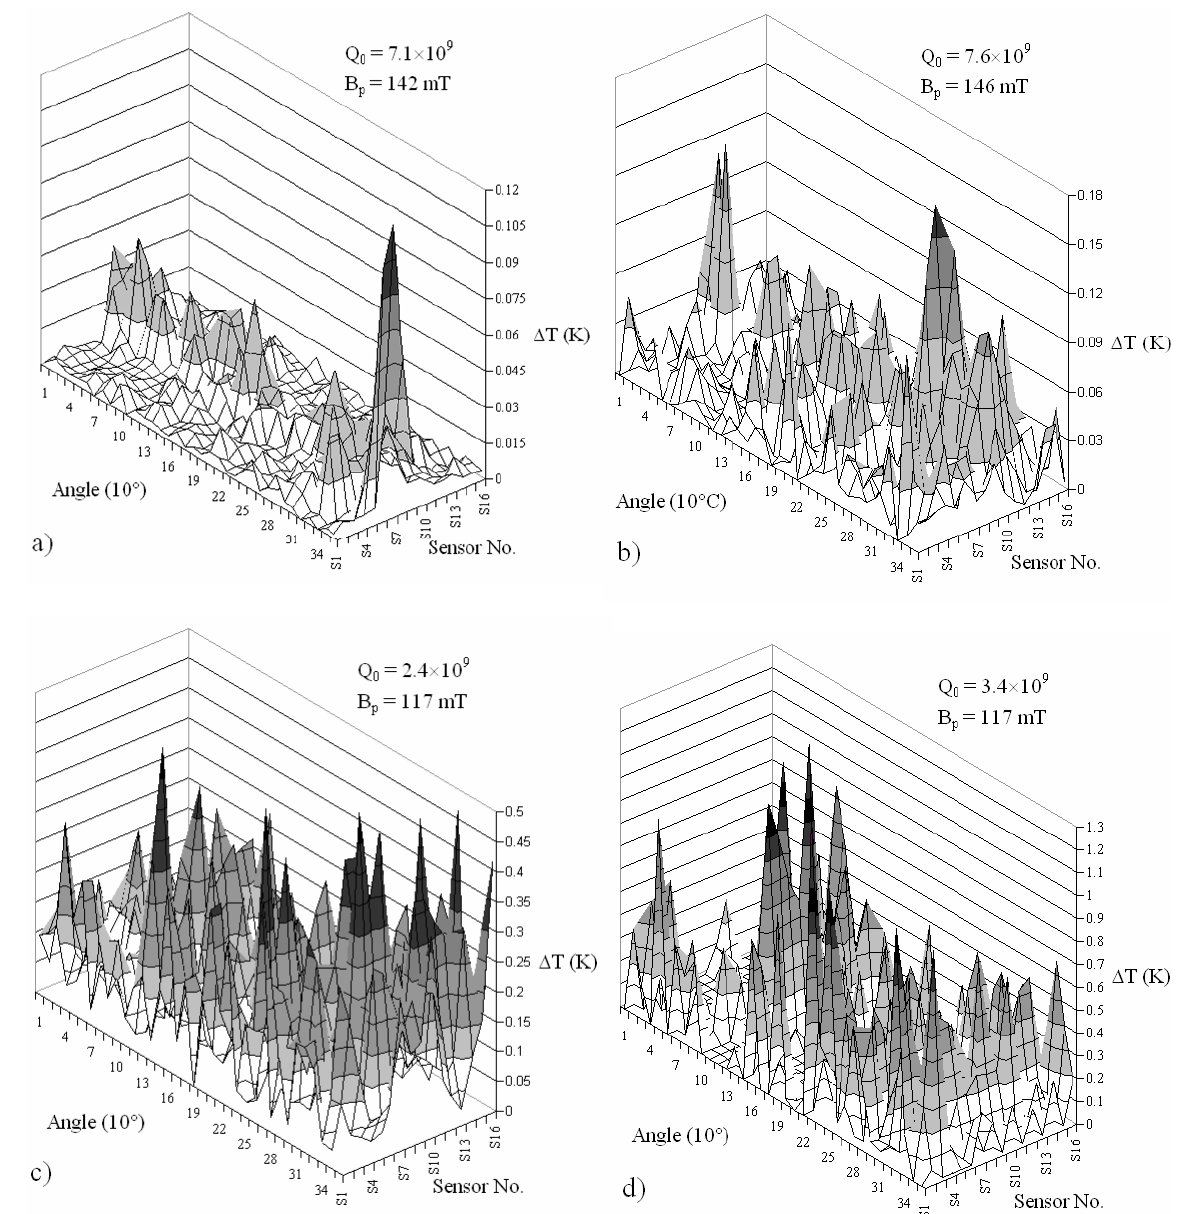
FIG. 7. Temperature maps at the He bath temperature of 1.7 K at the highest rf field achieved after 120 (cid:3) C 48 h baking in 1 atm of oxygen (a), 120 (cid:3) C 12 h baking in air (b), 180 (cid:3) C 12 h baking in air (c), and a total of 6 times HF rinses (d). Heating of the whole cavity surface and hot spots at the irises (high electric field area) occur after baking at 180 (cid:3) C . The higher (cid:2) T in (c) and (d) is due to a higher thermal response of the thermometers, possibly due to an increase of Kapitza resistance. Note the different (cid:2) T